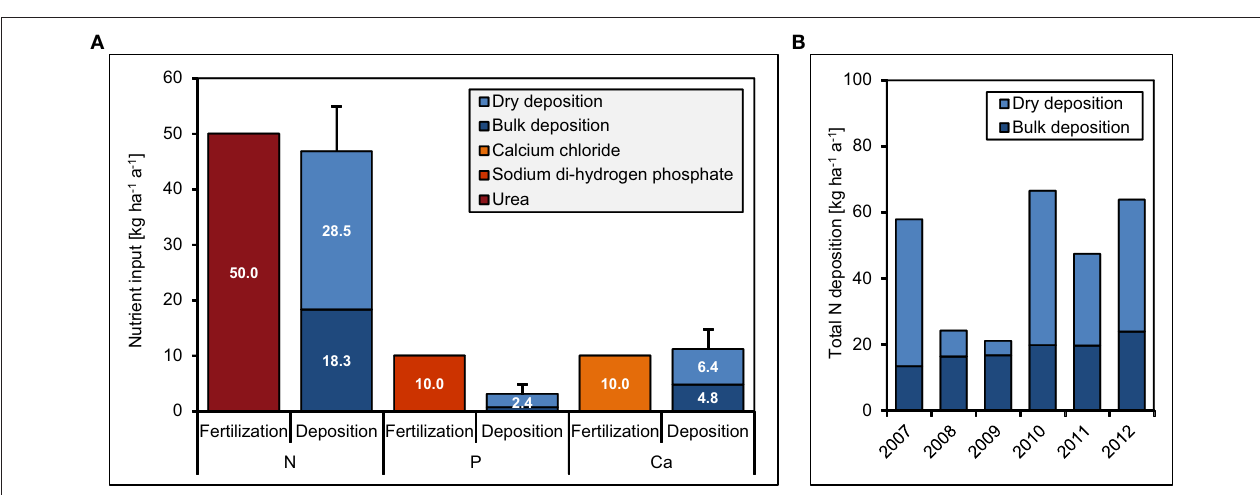
FIGURE 3 | Fertilization and deposition rates between 2007 and 2012 in the Nutrient Manipulation Experiment (NUMEX). The diagrams show (A) annual fertilization and deposition rates of N, P, and Ca and (B) total annual N deposition during the study period. Error bars indicate one standard error of average total deposition rates over the 5